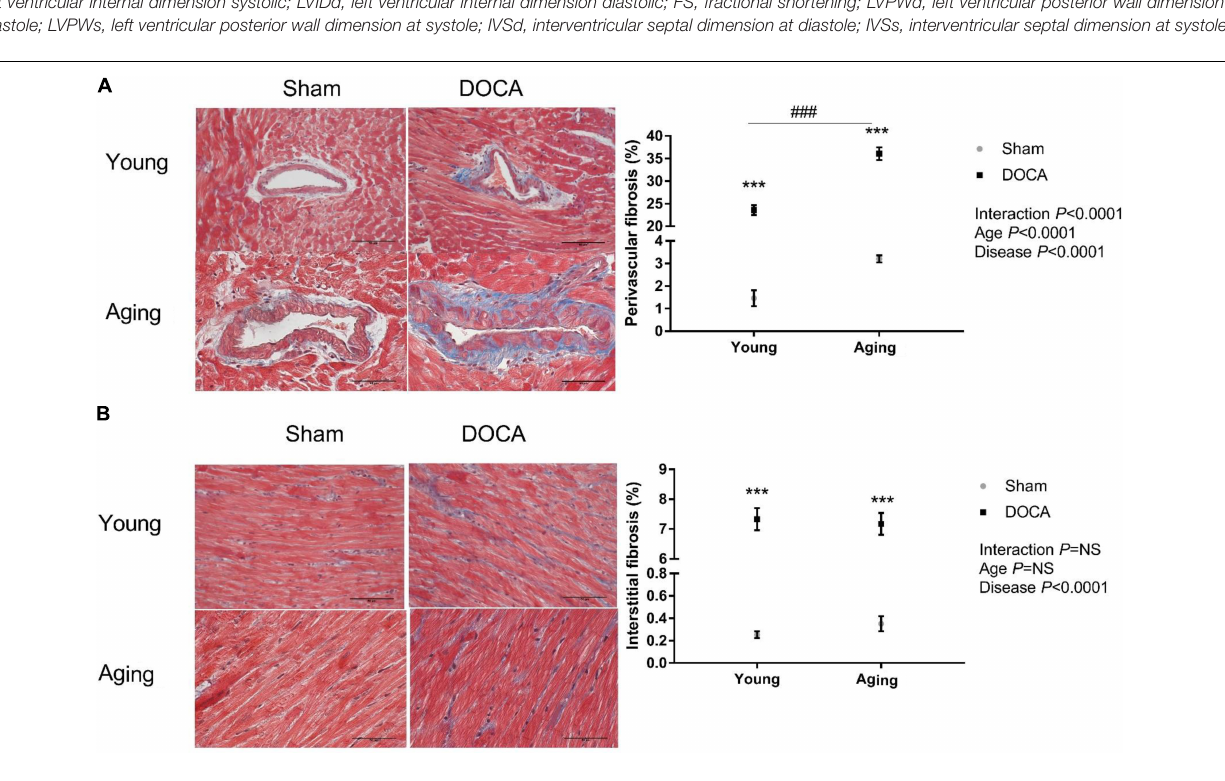
FIGURE 2 | Cardiac fibrosis of young and aging sham and DOCA mice. (A) Young and aging DOCA mice had higher perivascular and (B) interstitial fibrosis than sham mice. However, aging mice had more perivascular fibrosis than young mice. Values are mean ± SEM. ∗ q < 0.05, ∗∗ q < 0.01, ∗∗∗ q < 0.001 DOCA vs.